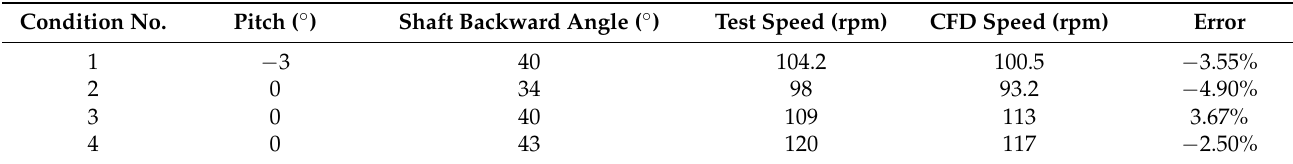
Table 2. Rotational speed from tests and CFD.